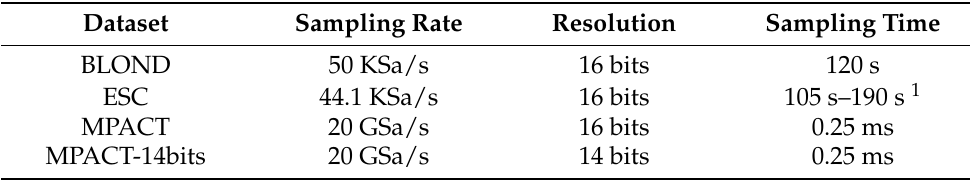
Table 2. The detailed information of the sensor datasets used in this paper.